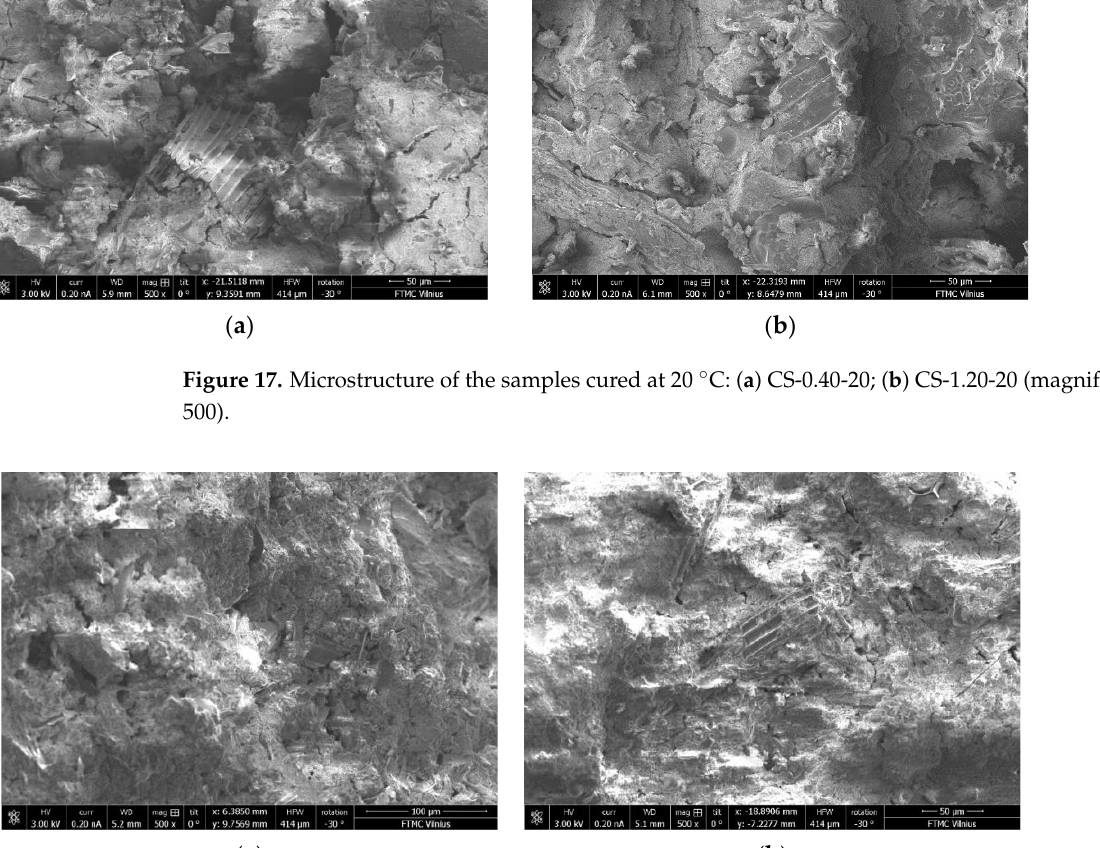
Figure 18. Microstructure of the samples cured at 40 °C: ( a ) CS-0.40-40; ( b ) CS-1.20-40 (magnification 500).